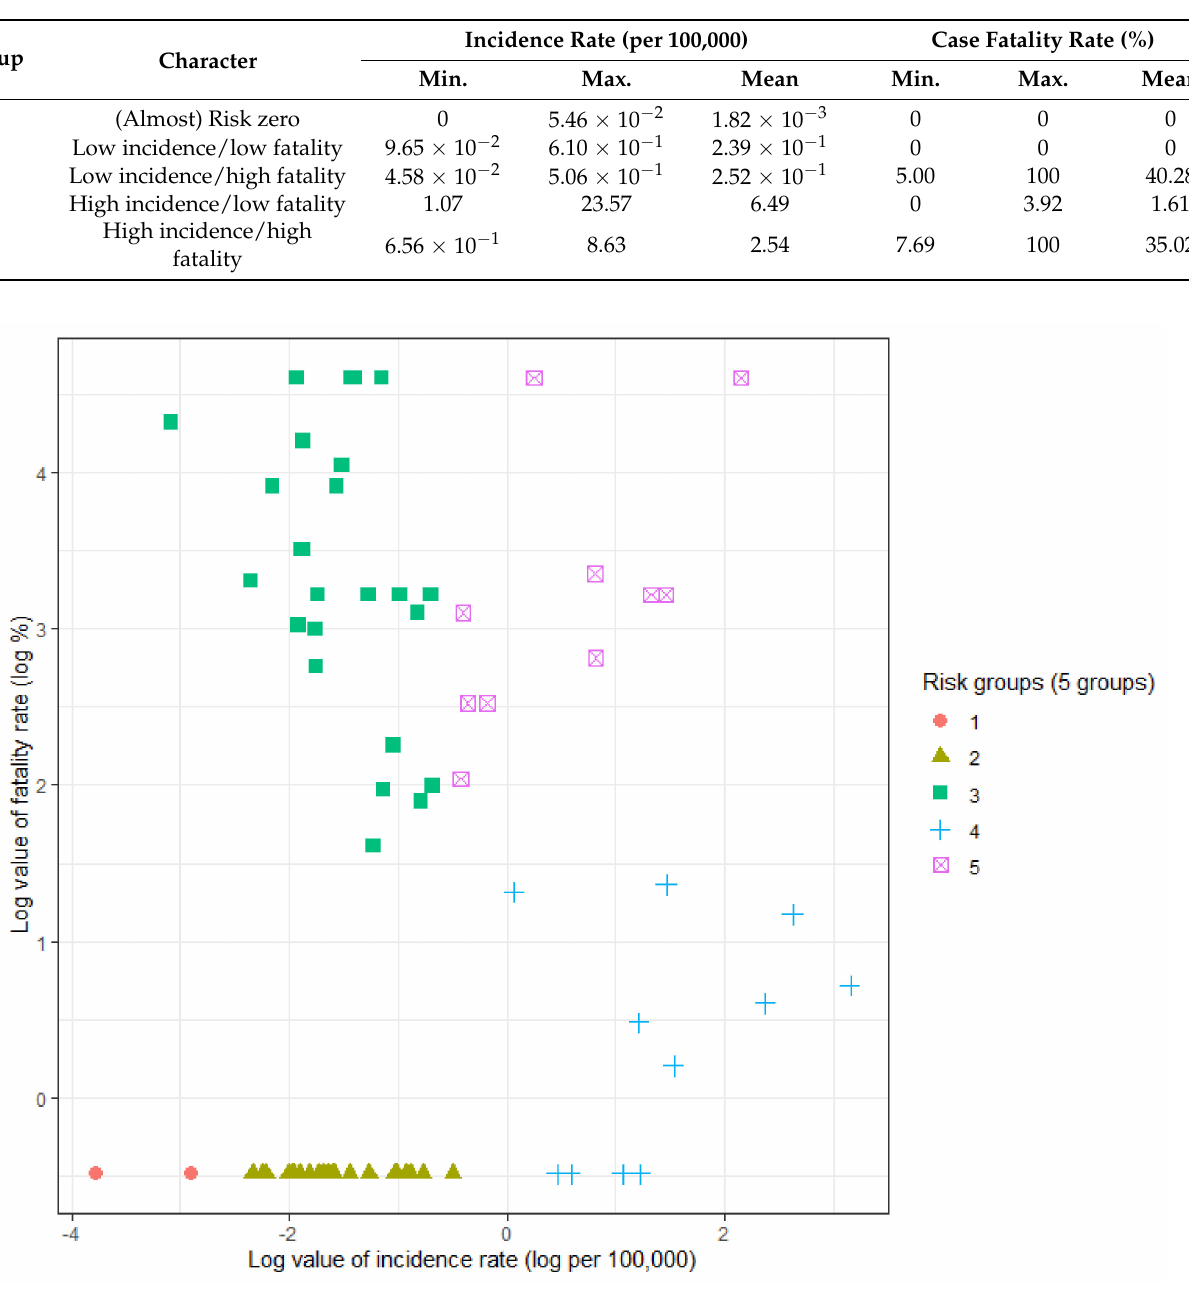
Figure 6. The distribution of incidence and fatality rates and risk groups among